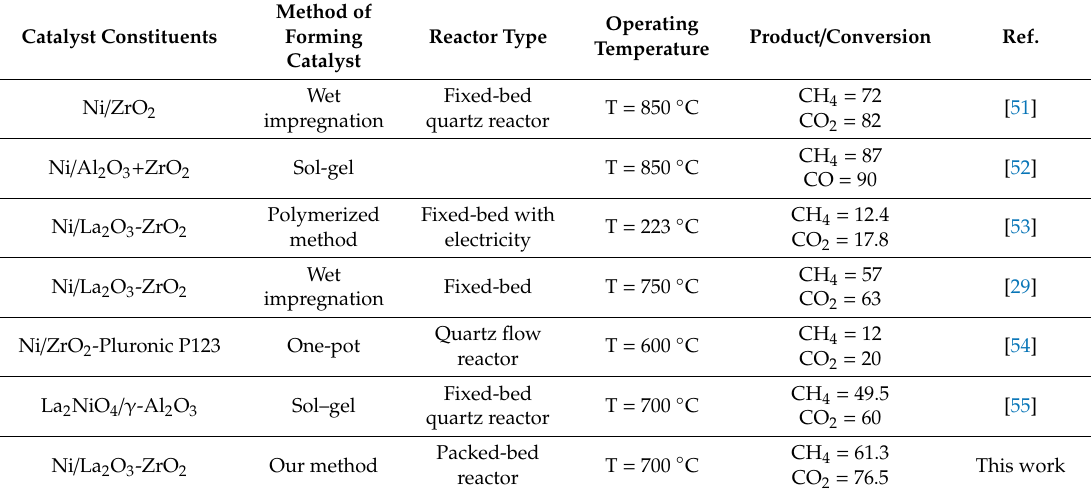
Table 2. Comparison of the results of this work with those of the literature.